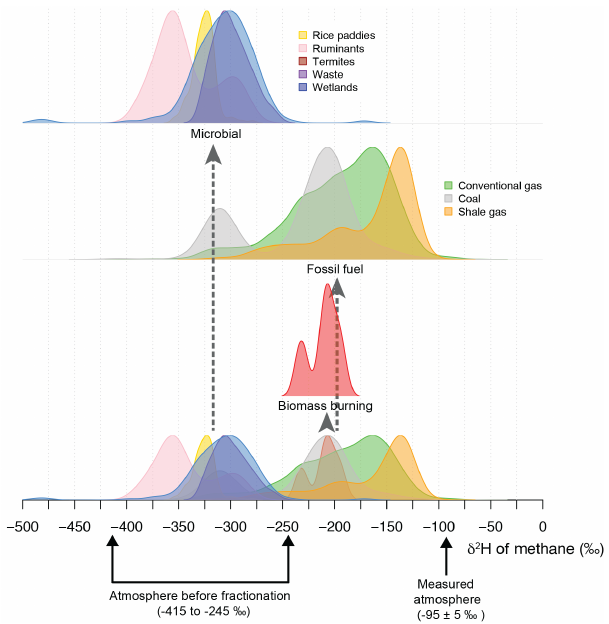
Figure 8. Normalized probability density distributions for the δ 2 H CH of microbial, fossil, and biomass burning sources of 4 methane. The flux-weighted average of all sources produces a mean atmospheric δ 13 C CH of between − 245 and − 415‰, as inferred 4 from measured atmospheric δ 2 H CH and isotopic fractionation as- 4 sociated with photochemical methane destruction (see